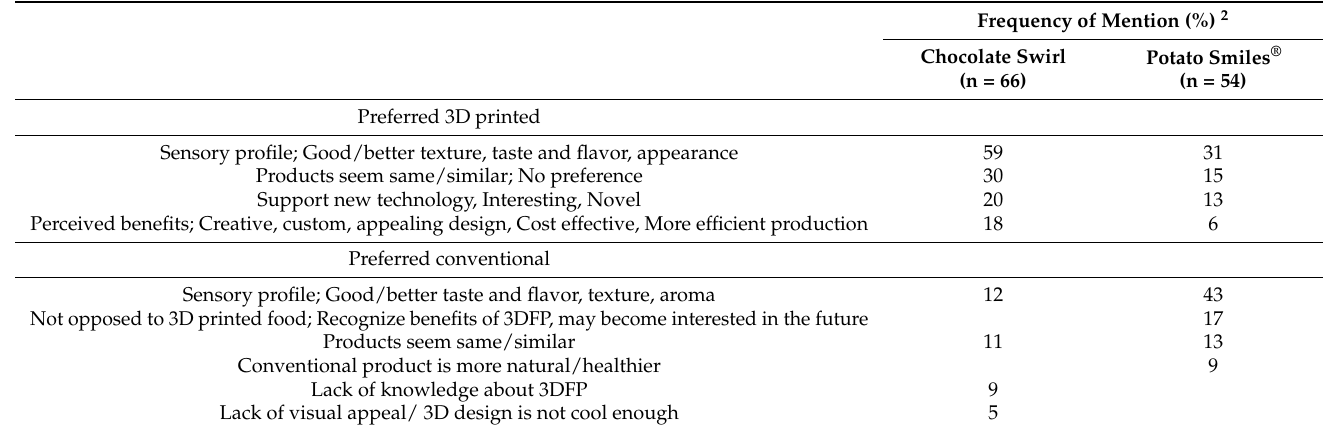
Table 5. Participant comments to support paired preference choice of 3D printed or conventional products 1